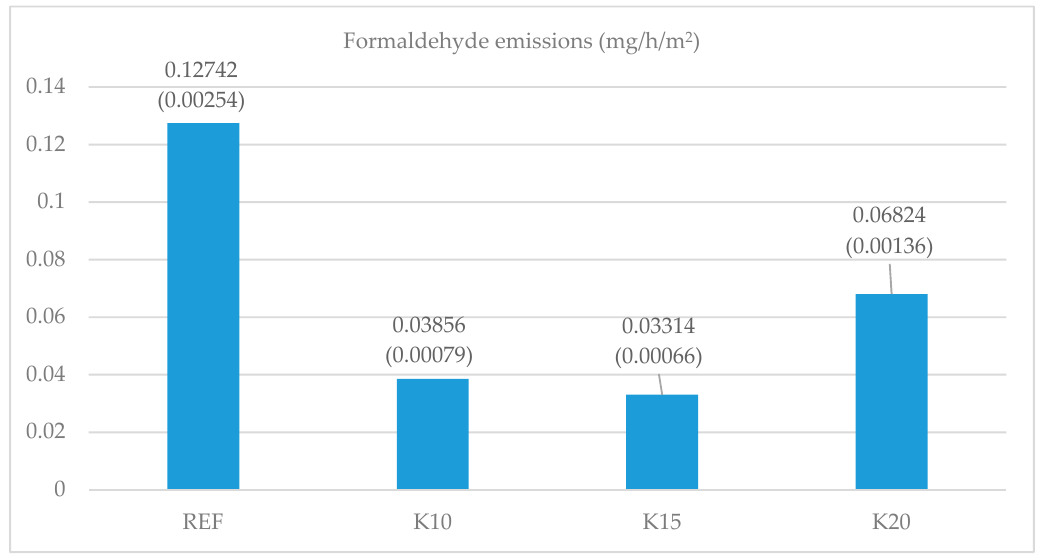
Figure 8. The e ff ect of adhesive mixtures on formaldehyde emissions (values in parenthesis are Figure 8. The effect of adhesive mixtures on formaldehyde emissions (values in parenthesis are standard standard deviations).